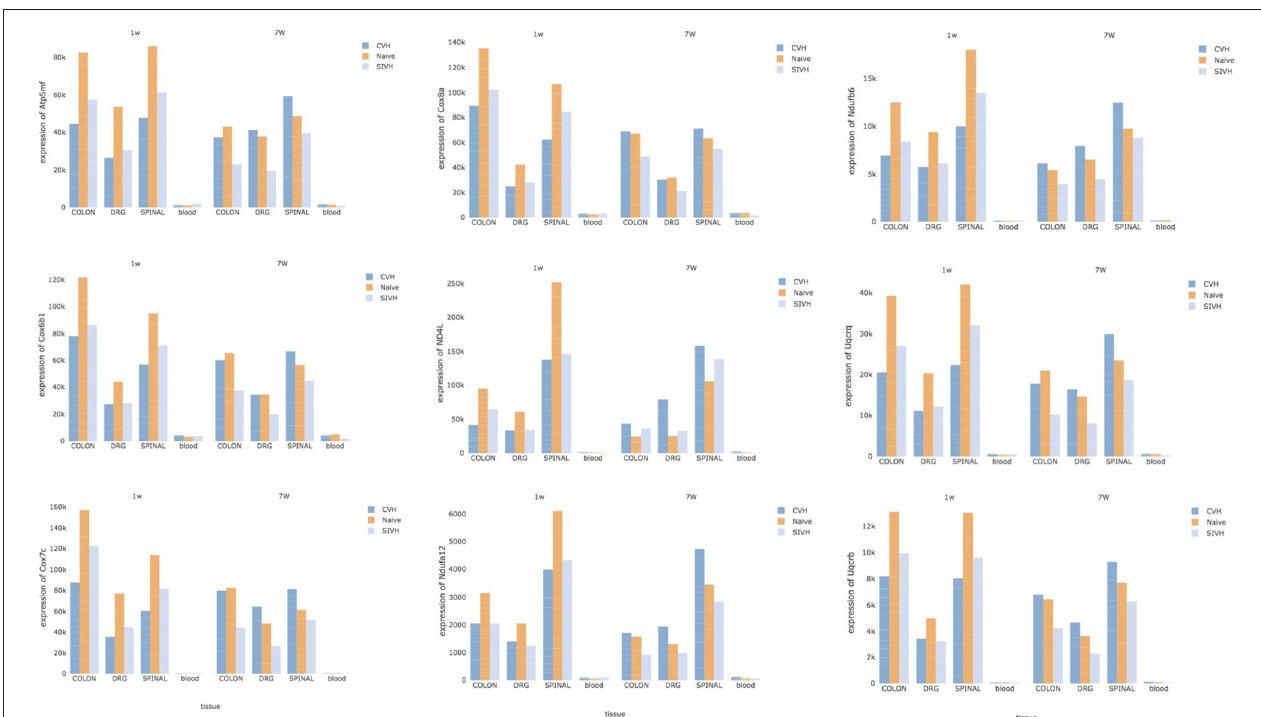
FIGURE 5 | Potential CPH biomarkers in blood. The figure shows 9 genes, representative of mitochondrial membrane ATP synthase, cytochrome c oxidase, NADH: ubiquinone oxidoreductase (complex I) and ubiquinol-cytochrome c oxidoreductase complex. Since these genes showed high correlation of their expression profiles across the solid tissues (DRG, colon, and spinal) and blood, they represent potential diagnostic biomarkers for